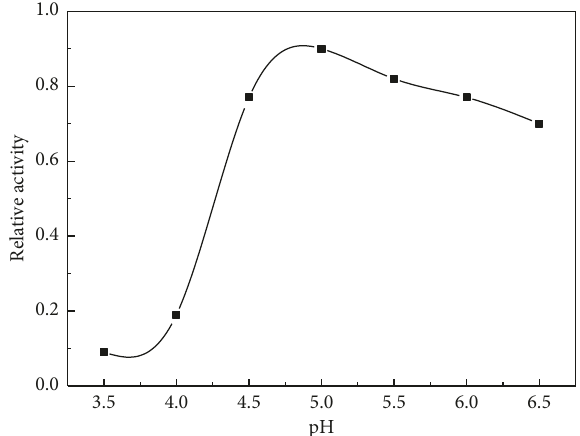
Figure 2: Relative activity of the enzyme system as a function of the pH. After pH 4.8, the enzymatic degradation begins. (cid:29)